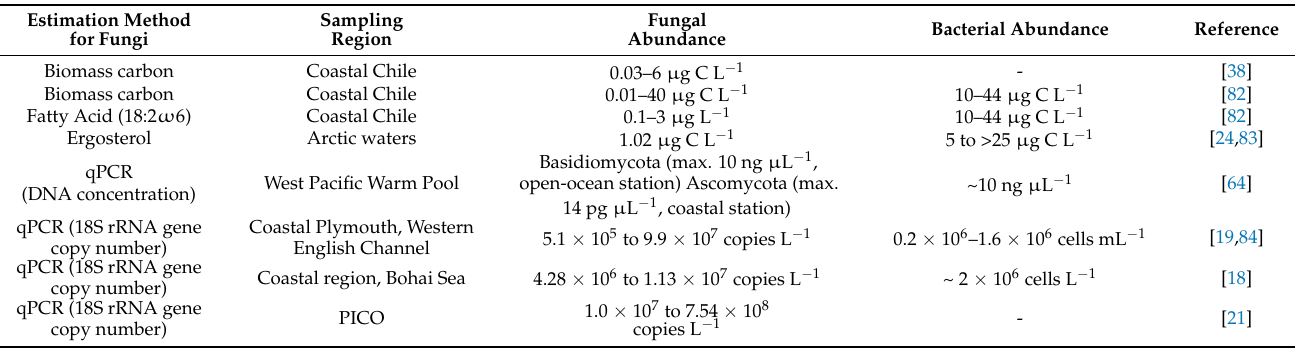
Table 4. Abundance of planktonic fungi in various oceanic regions estimated by different methods and their comparison with bacterial